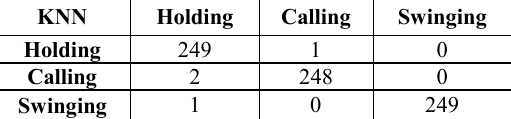
Table 3. The confusion matrix for smartphone modes